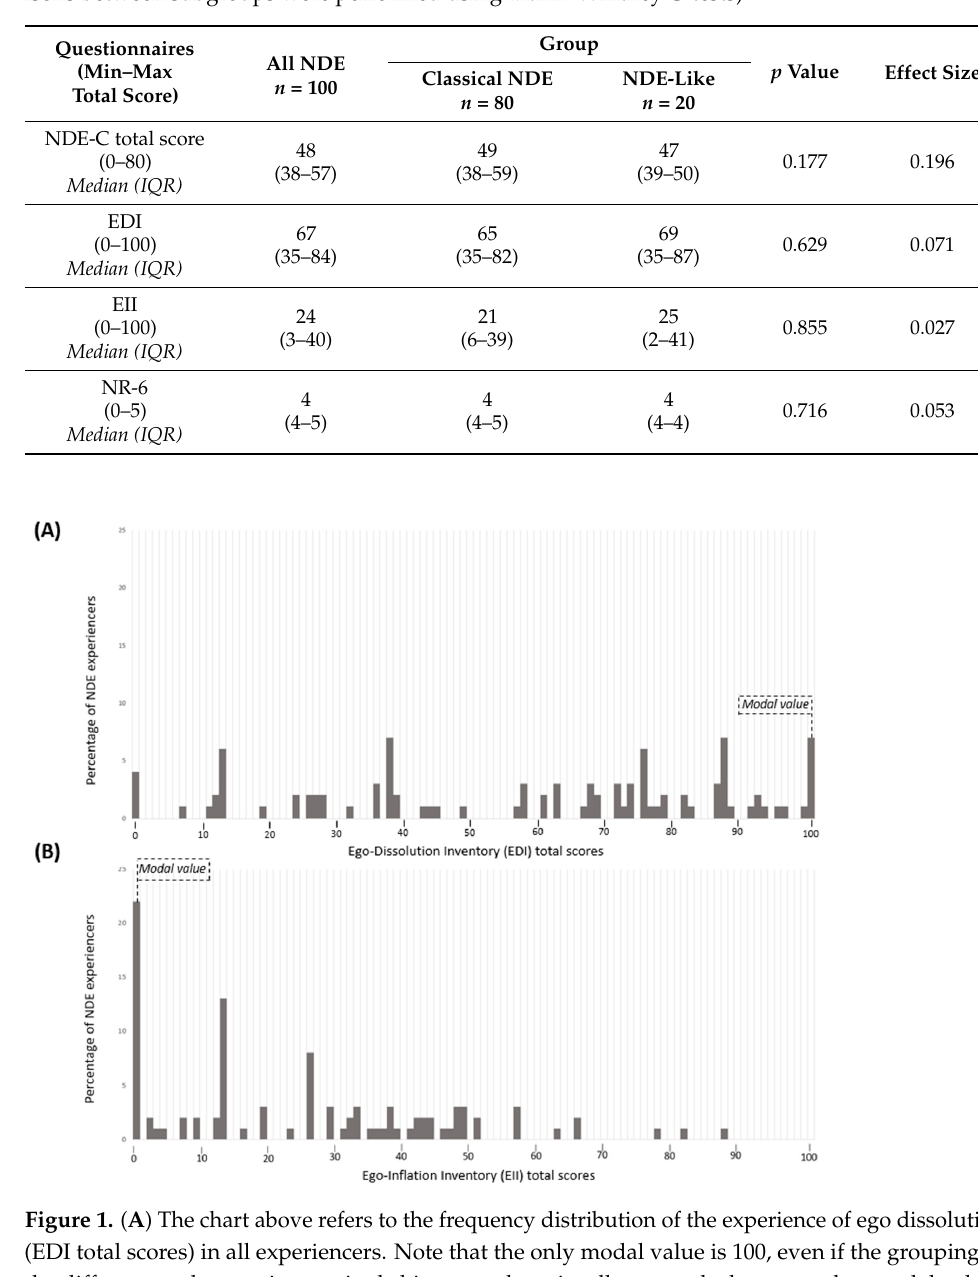
Table 2. Total scores of all questionnaires for the whole sample, and for the two subgroups (compar- isons between subgroups were performed using Mann–Whitney U tests).